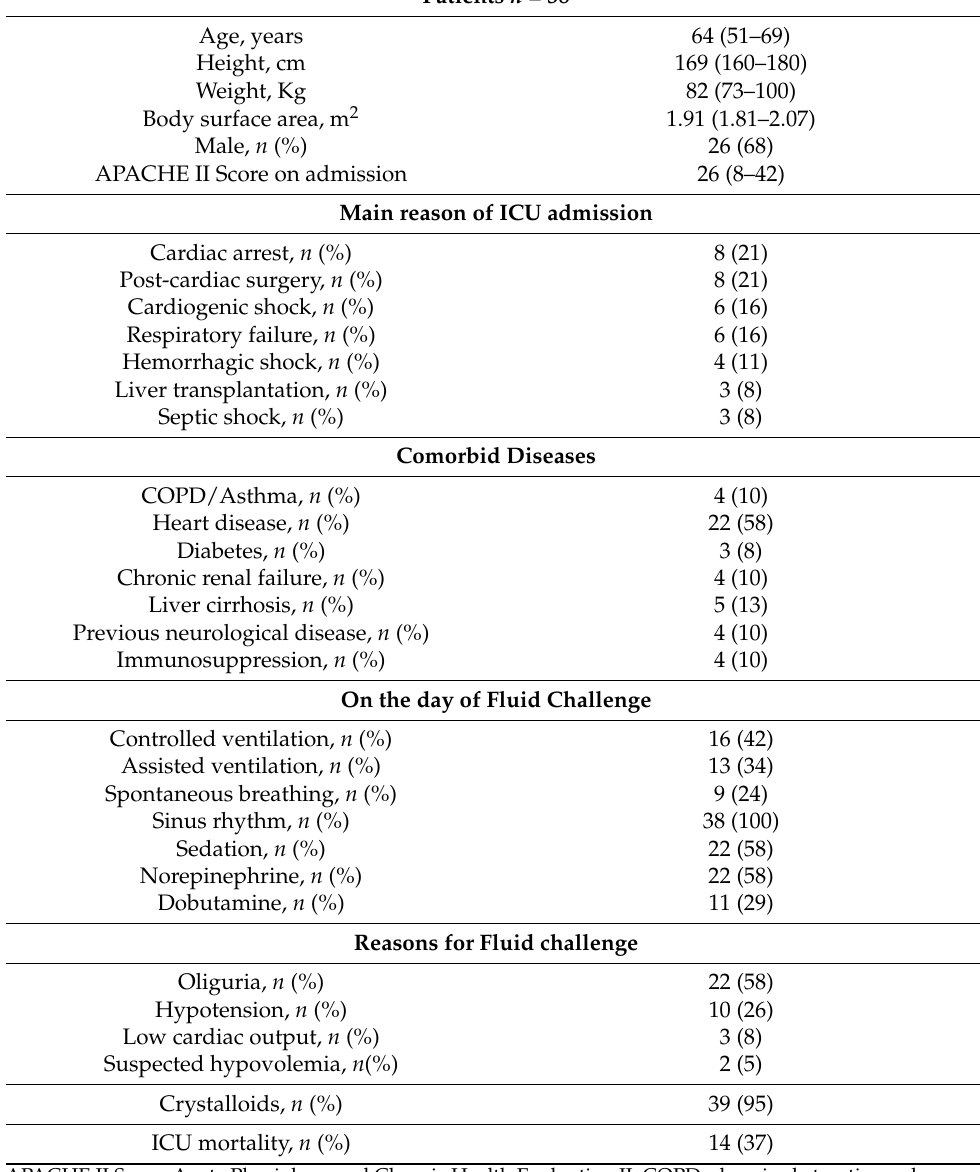
Table 1. Demographics and data on the day of fluid challenge. Data are presented as median (IQRs) or count and